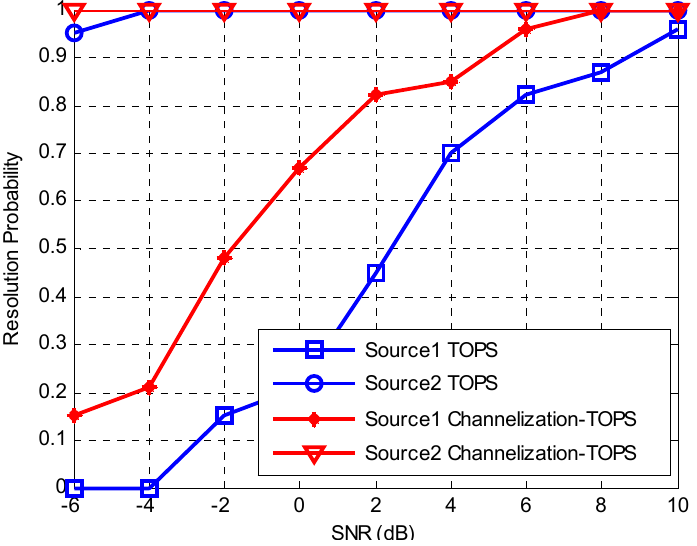
Figure 8. Resolution probability versus SNR with ISM and Channelization-ISM method.